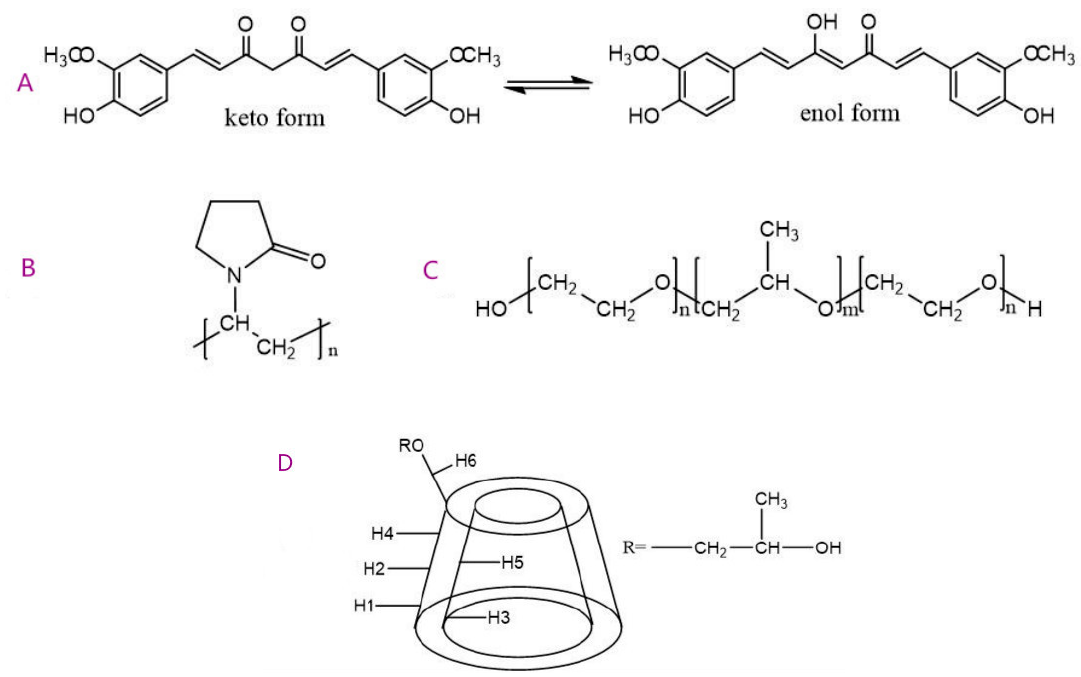
Figure 1. Chemical structures of ( A ) Curcumin (Cur) in keto-enol tautomeric equilibrium; ( B ) PVP K30; ( C ) poloxamer 188; and ( D ) HP- β -CD.